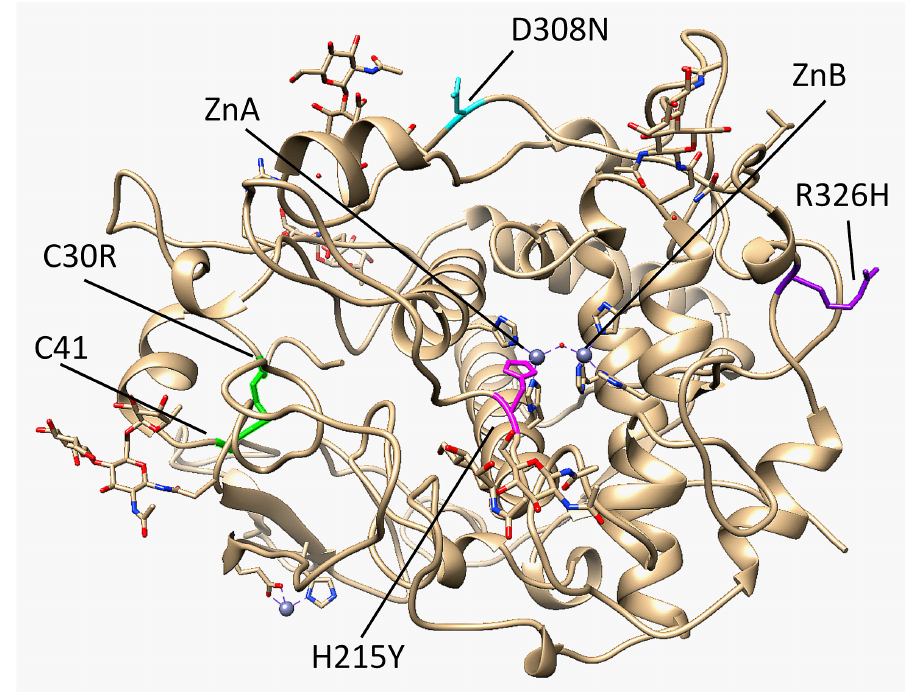
Figure 1. Location of each OCA3 mutant of interest in the Tyrp1 crystal structure (chain A of 5M8L). C30, C41, and the corresponding disulfide bridge are highlighted in green, H215 is highlighted in magenta, D308 is highlighted in cyan, R326 is highlighted in purple, and ZnA and ZnB are shown by grey spheres.